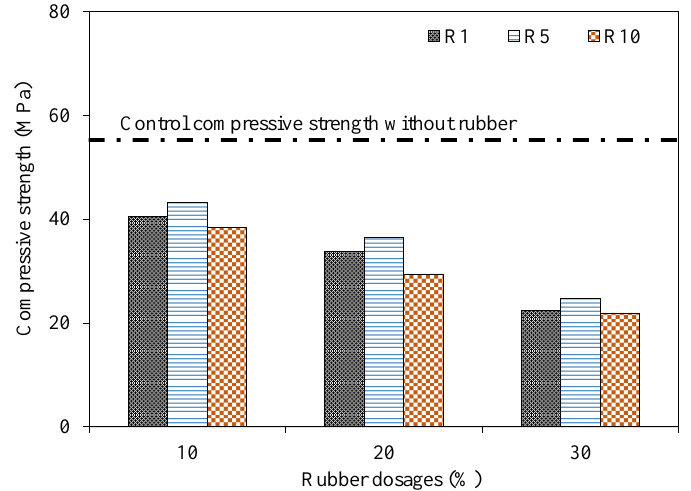
Figure 8. Compressive strength for the mixture incorporating various dosages of rubber at 28 days.